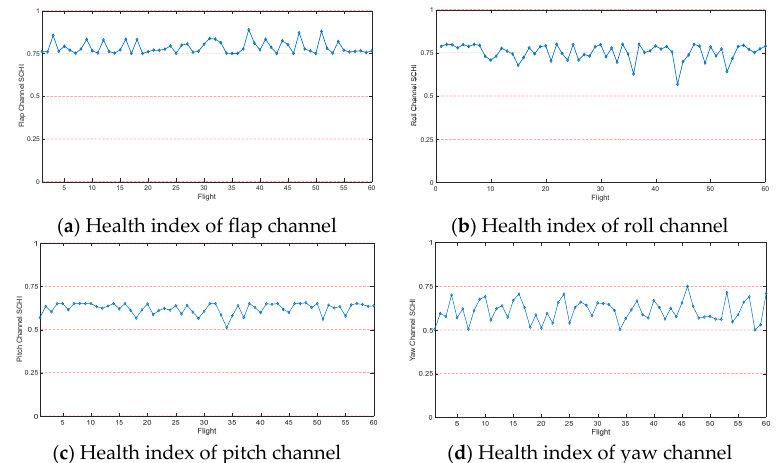
Figure 9. Health index of each channel. Appl. Sci. 2021 , 11 , x FOR PEER REVIEW